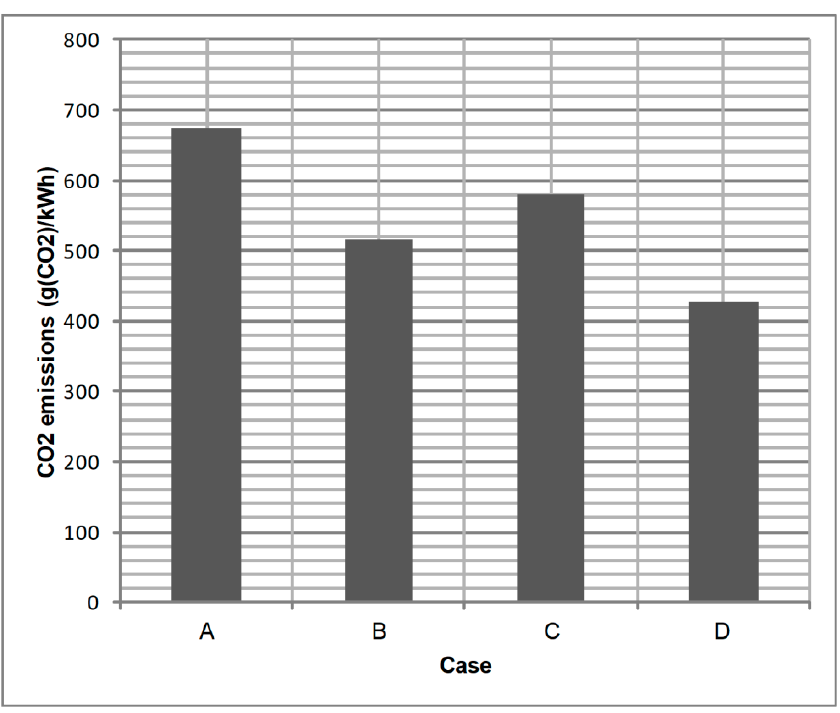
Figure 5. Comparison of the four cases under study in terms of the unit cost of electricity (in USD/kWh).